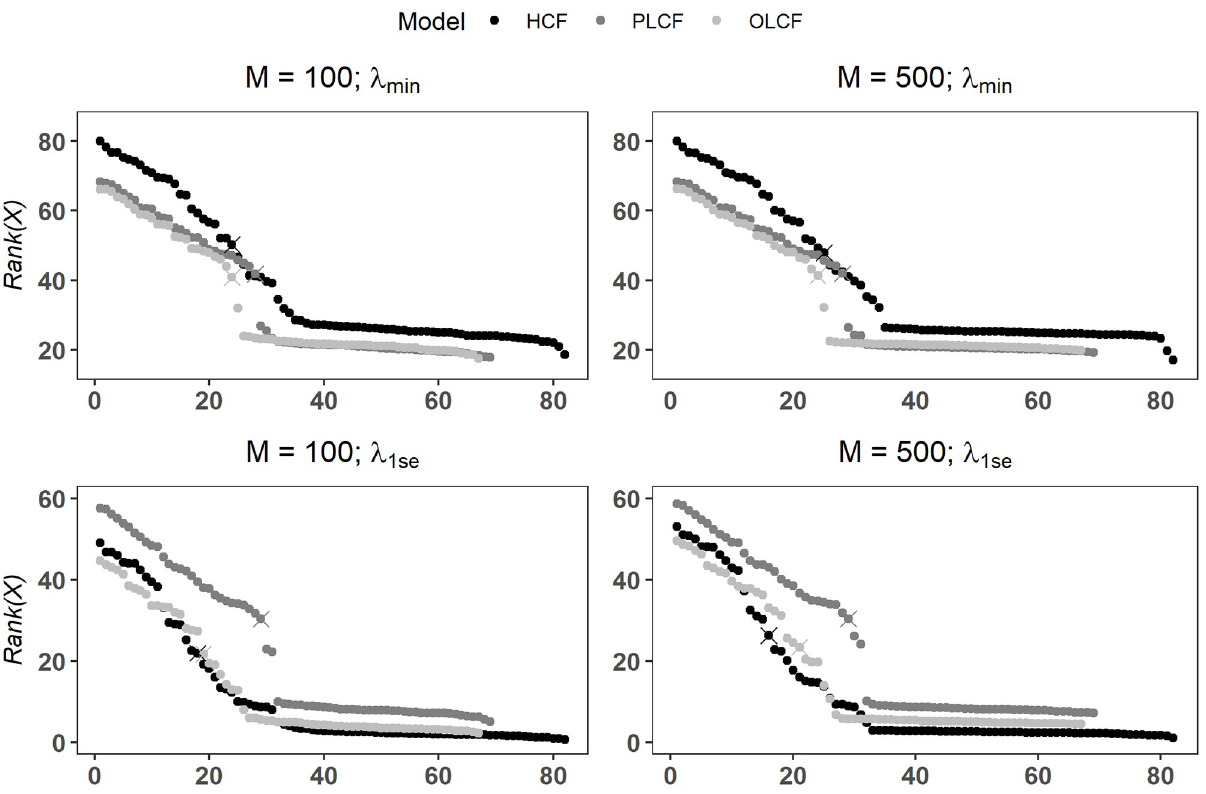
Fig 7. Lasso regularization-based variable rank scores computed using SVRS algorithm for various wildland fire occurrence models. Symbol × marks a changepoint point in sorted Rank ( X ) values where variables falling to the right of × are classified be noise covariates.